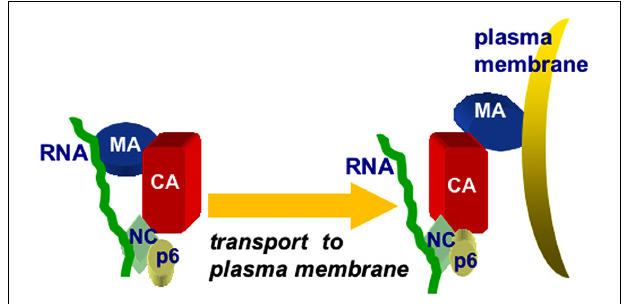
FIGURE 4 | Chaperone model for MA–RNA binding. The chaperone model for MA-RNA binding posits that both the MA and NC domains of PrGag proteins bind to RNA in the cytoplasm of infected cells, and that the MA–RNA binding protects MA from binding to inappropriate intracellular membranes, lacking PI(4,5)P2. Once at PI(4,5)P2-rich sites at the plasma membrane, MA binding switches from RNA to PI(4,5)P2, facilitating the trafficking and assembly of PrGag